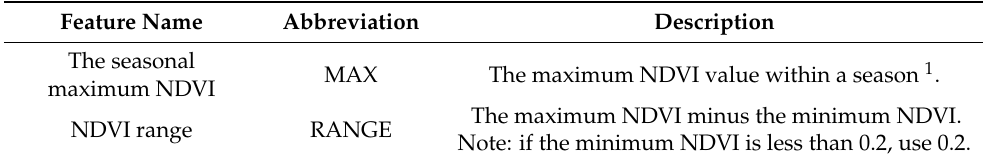
Table 1. Two critical NDVI features used in the thresholding